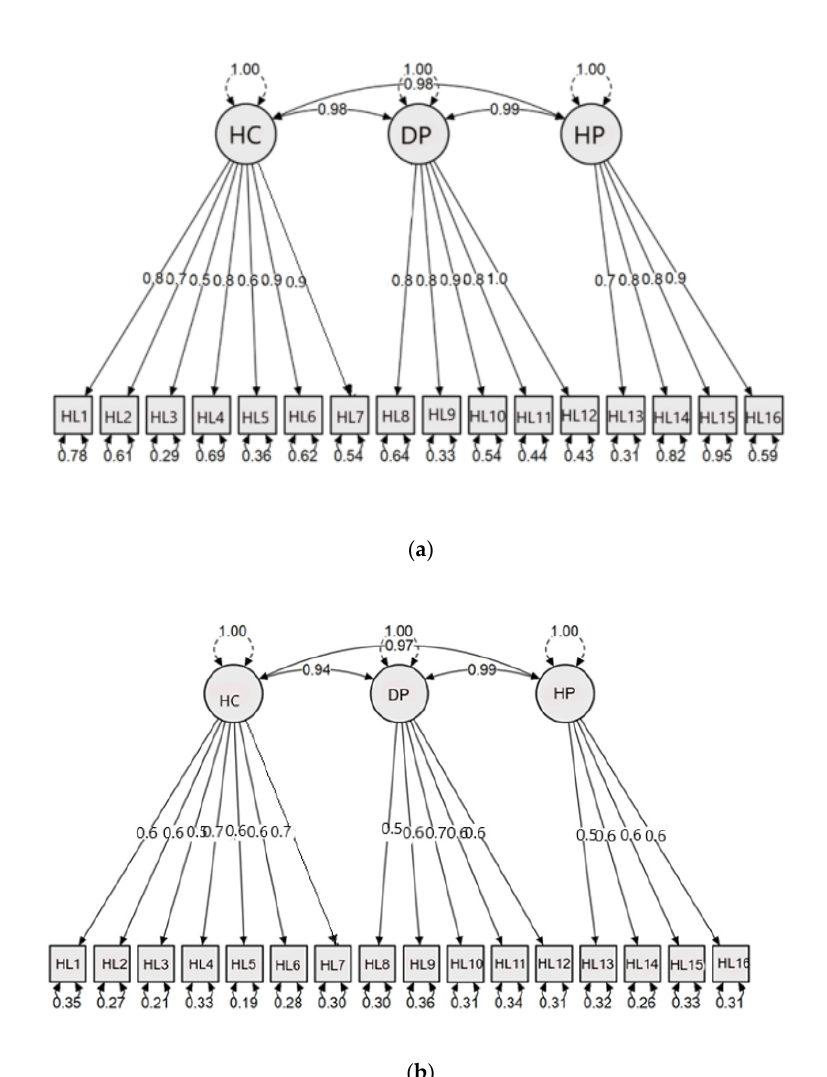
Figure 1. Measurement model and factor loadings for the Indian versions of the European Health Literacy Survey Questionnaire (HLS-EU-Q)16. ( a ) Hindi version (chi square (X 2 ) = 123.884, df = 101, root mean square error of approximation (RMSEA) = 0.06). ( b ) Kannada version (chi square = 212.822, df = 101, RMSEA = 0.07). HC: Health Care; DP: Disease Prevention; HP: Health Promo-